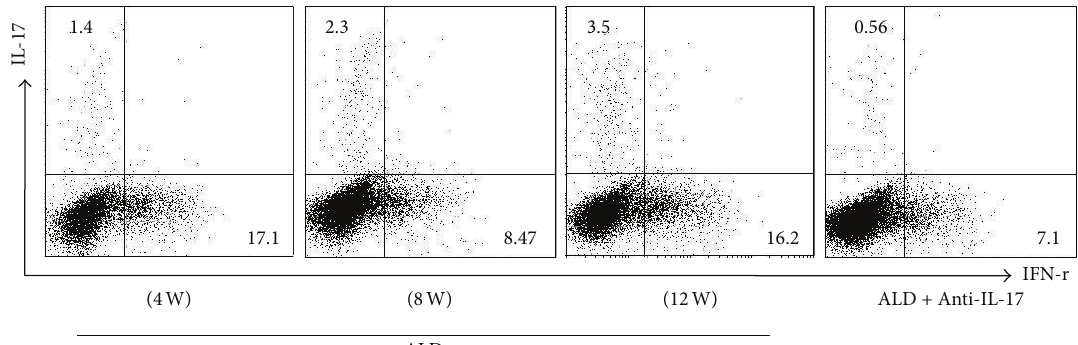
Figure 3: Activation of a peripheral IL-17-secreting phenotype in liver tissue of every ALD group. Data are representative of three separate experiments.